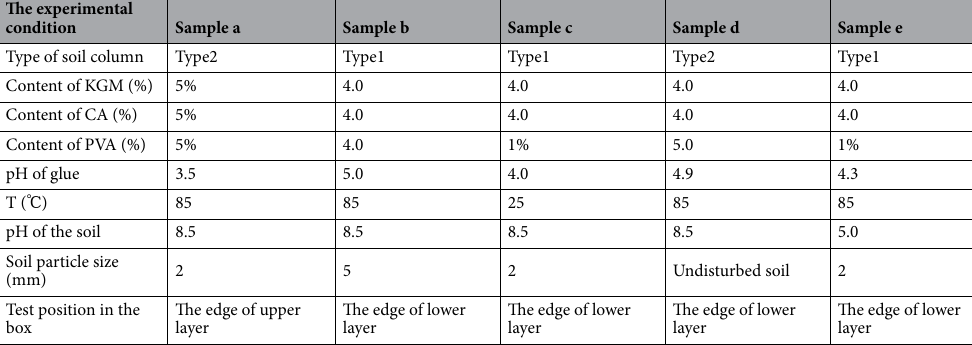
Table 1. The experimental conditions of typical soil column samples a–e.